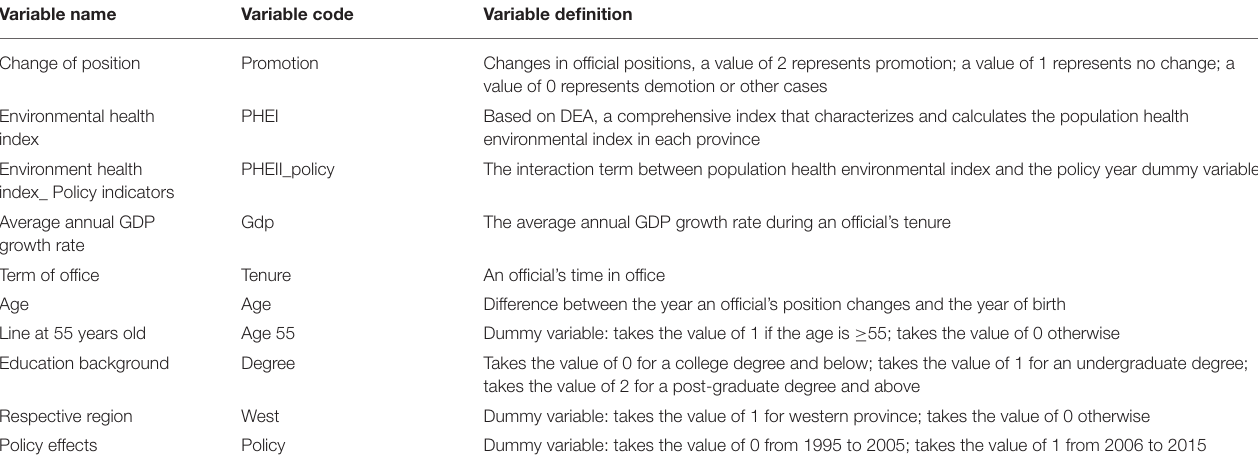
TABLE 1 | Description of